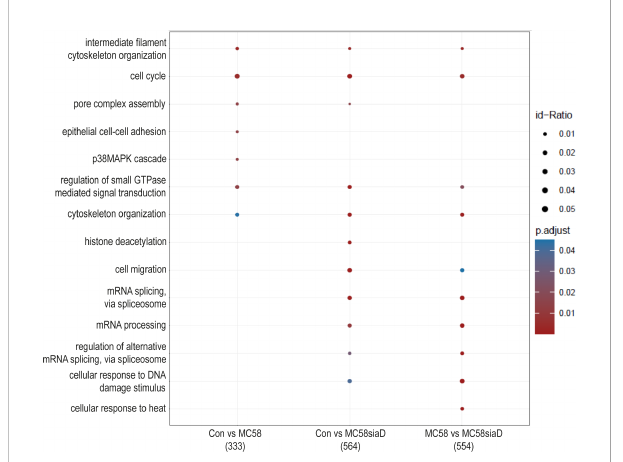
FIGURE 5 Enrichment analysis of biological processes after infection with N.